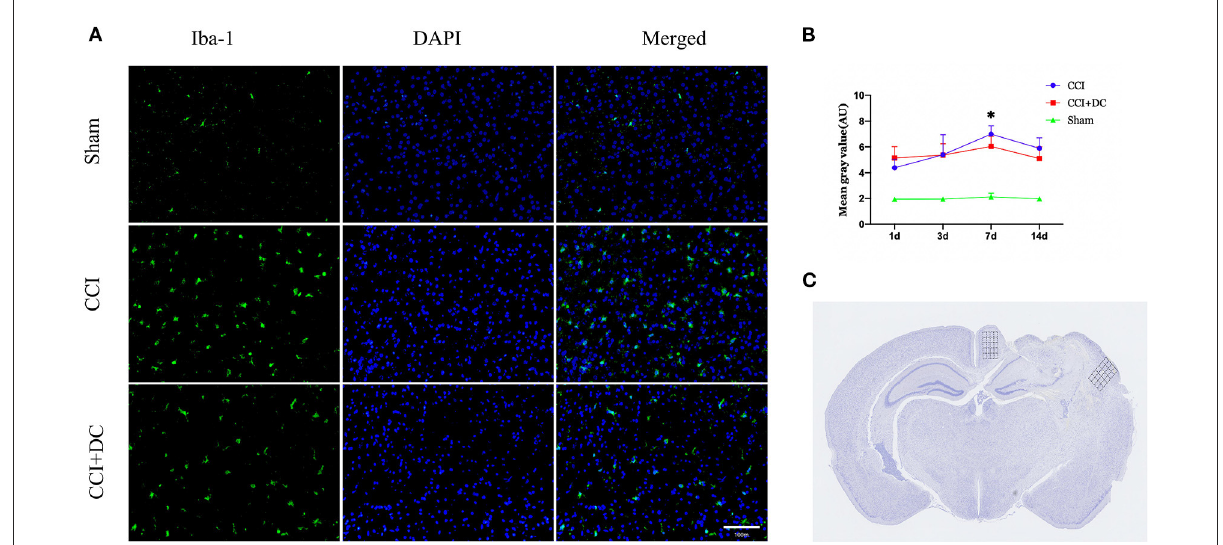
FIGURE10 Effect on peri-contusional cortex microglia. (A) The expression of microglia in different groups on the 7th day after traumatic brain injury. (B) Expression of microglia in the CCI + DC group was significantly lower than that in the CCI group on the 7th day after CCI, the expression of cortical microglia was statistically different from that in the CCI group. (C) Detected areas of microglia and astrocytes. n = 6/group/time points, * P < 0.05, vs. CCI group.